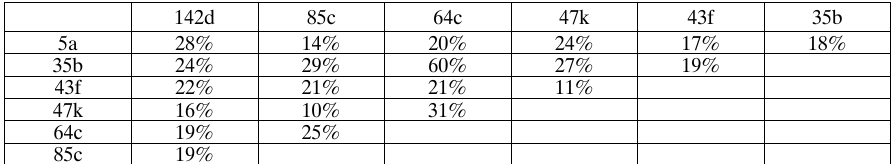
Similarities of soil fungi communities coming from